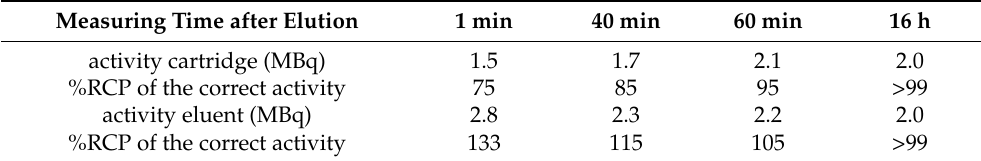
Table 1. Manual testing of trapping efficiency of the CM cartridge by a mixture of 2.0 MBq free 225 Ac and 2.1 MBq 225 Ac-labeled peptide by comparison of the measured activities and radiochemical purity (RCP). Measuring Time after Elution 1 min 40 min 60 min 16 h activity cartridge (MBq) 1.5 activity eluent